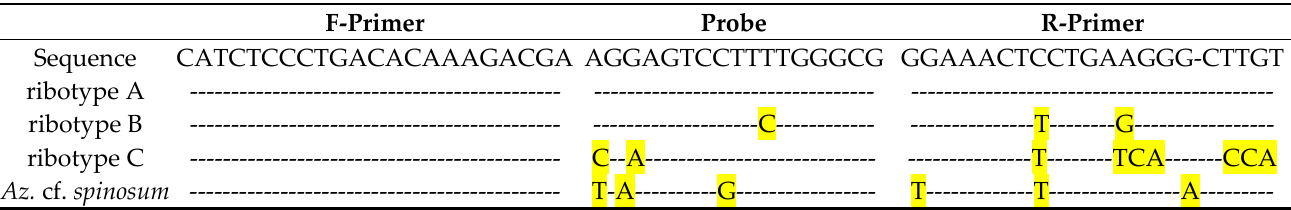
Table 3. Sequence alignment of the Az. spinosum specific qPCR primers and probe with the respective ribotype homologous. Base-pair differences to the primer or probe sequence are highlighted in yellow.